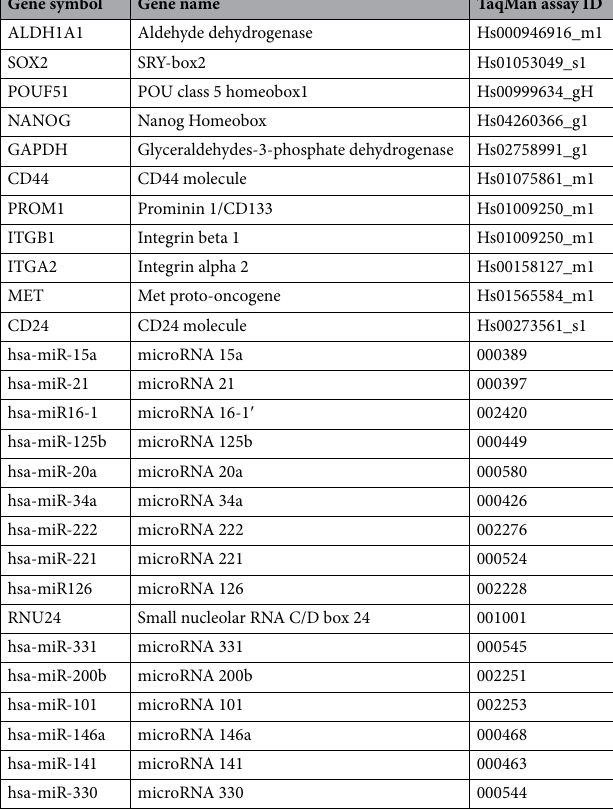
Table 1. qRT-PCR primer